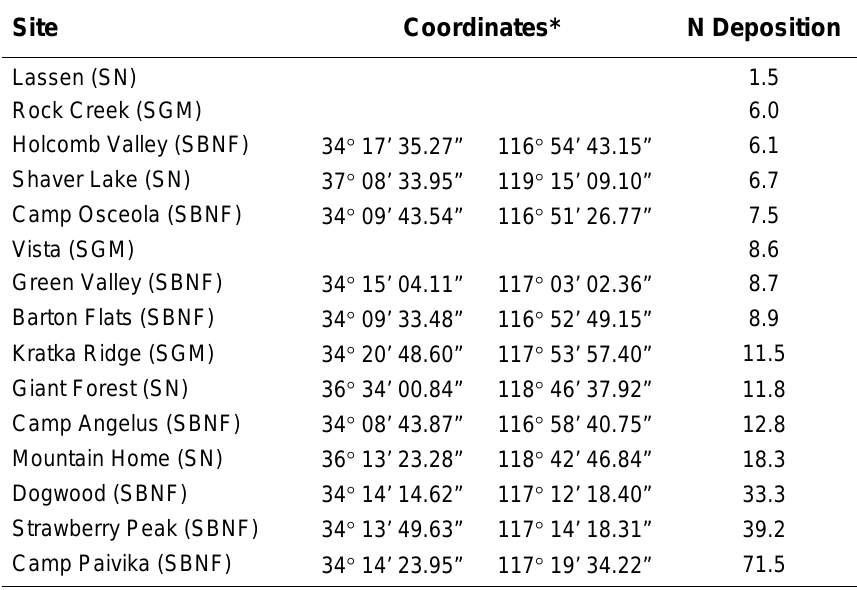
Throughfall N Deposition at 15 Sites from the Sierra Nevada (SN), San Gabriel Mountains (SGM), and San Bernardino National Forest